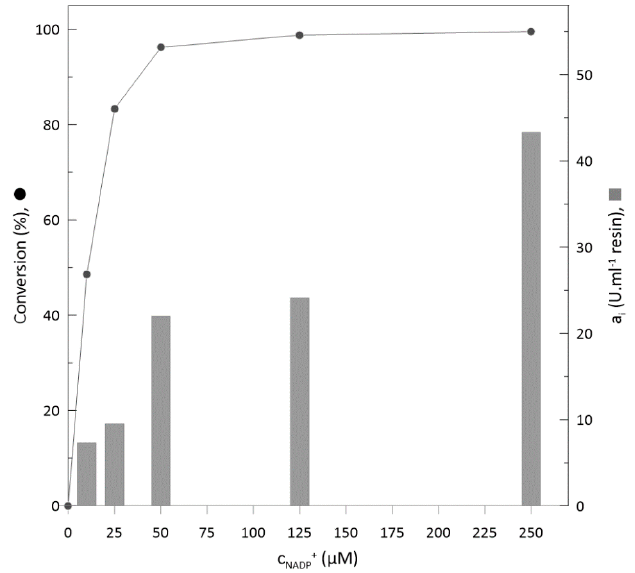
Figure 6. Substrate conversions and initial activity of immobilised enzymes with different cofactor